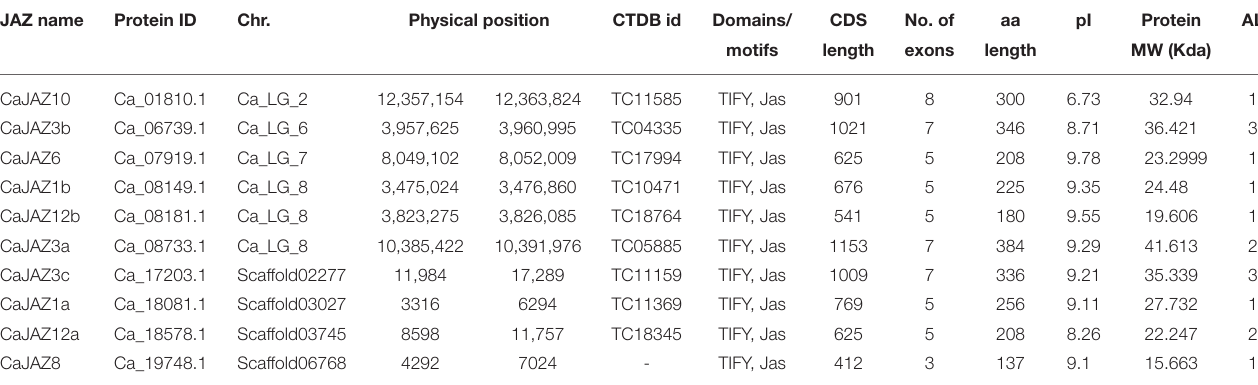
TABLE 1 | Structural and coding details of chickpea JAZ